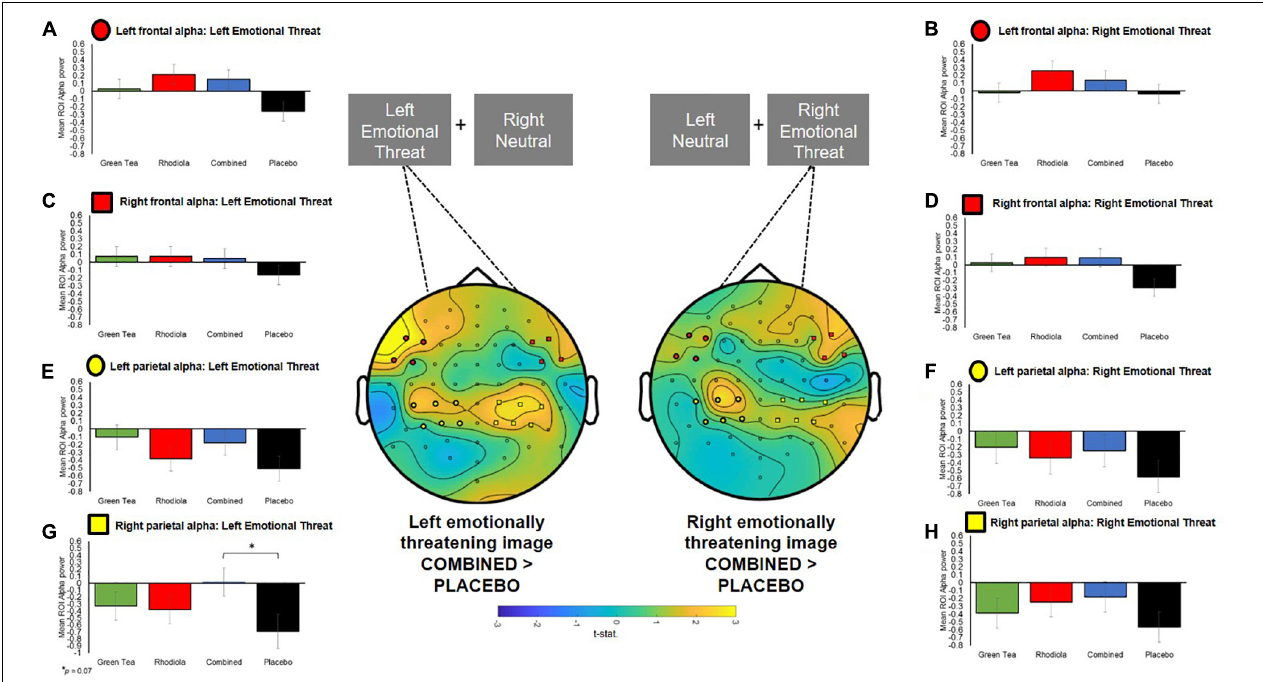
FIGURE 6 | Central figure: T-statistics maps of alpha difference between COMBINED and PLACEBO treatments 0.5–0.75 s after presentation of the images, distinguished by left and right emotionally threatening image presentation. Positive values in maps indicate COMBINED > PLACEBO. ROI electrodes symbols shown on maps and in respective summary bar charts. (A–D) Ipsilateral and contralateral frontal a priori defined ROI alpha band power when emotionally threatening image shown on left and right. (E–H) Ipsilateral and contralateral centro-parietal a priori defined ROI alpha band power when emotionally threatening image shown on left and